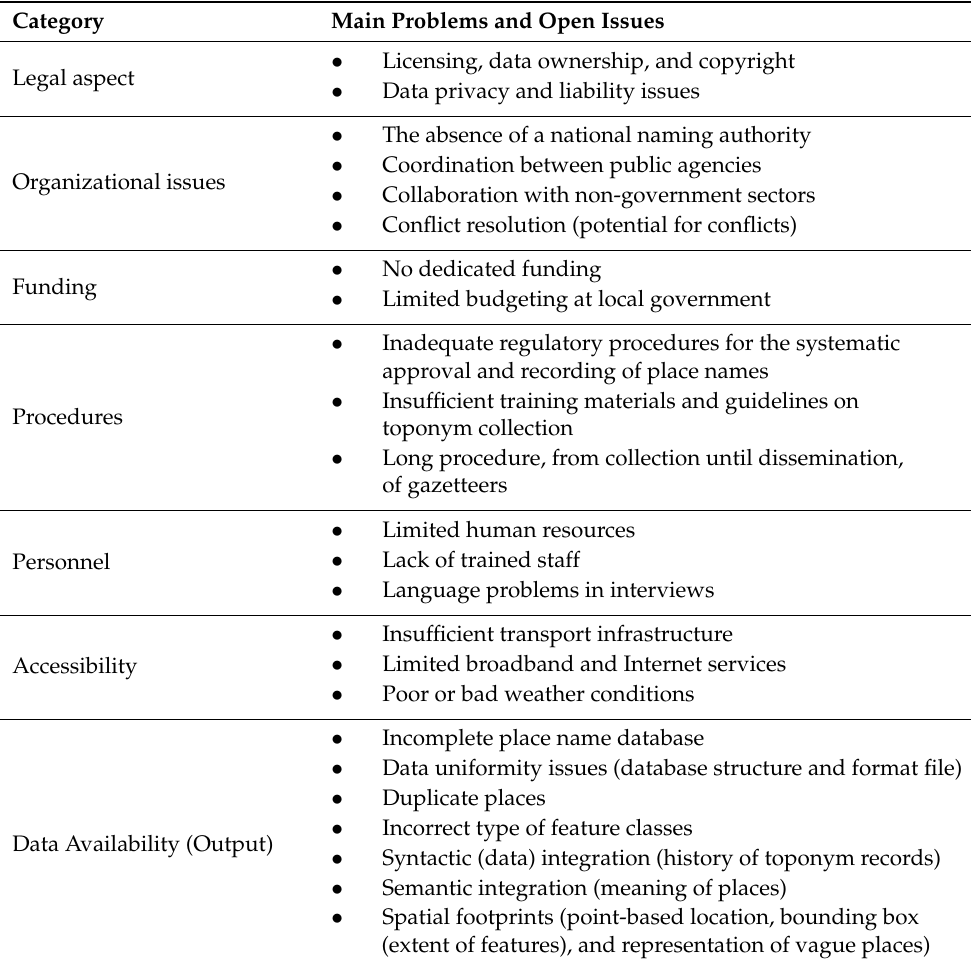
Table 1. Taxonomy of problems in toponym